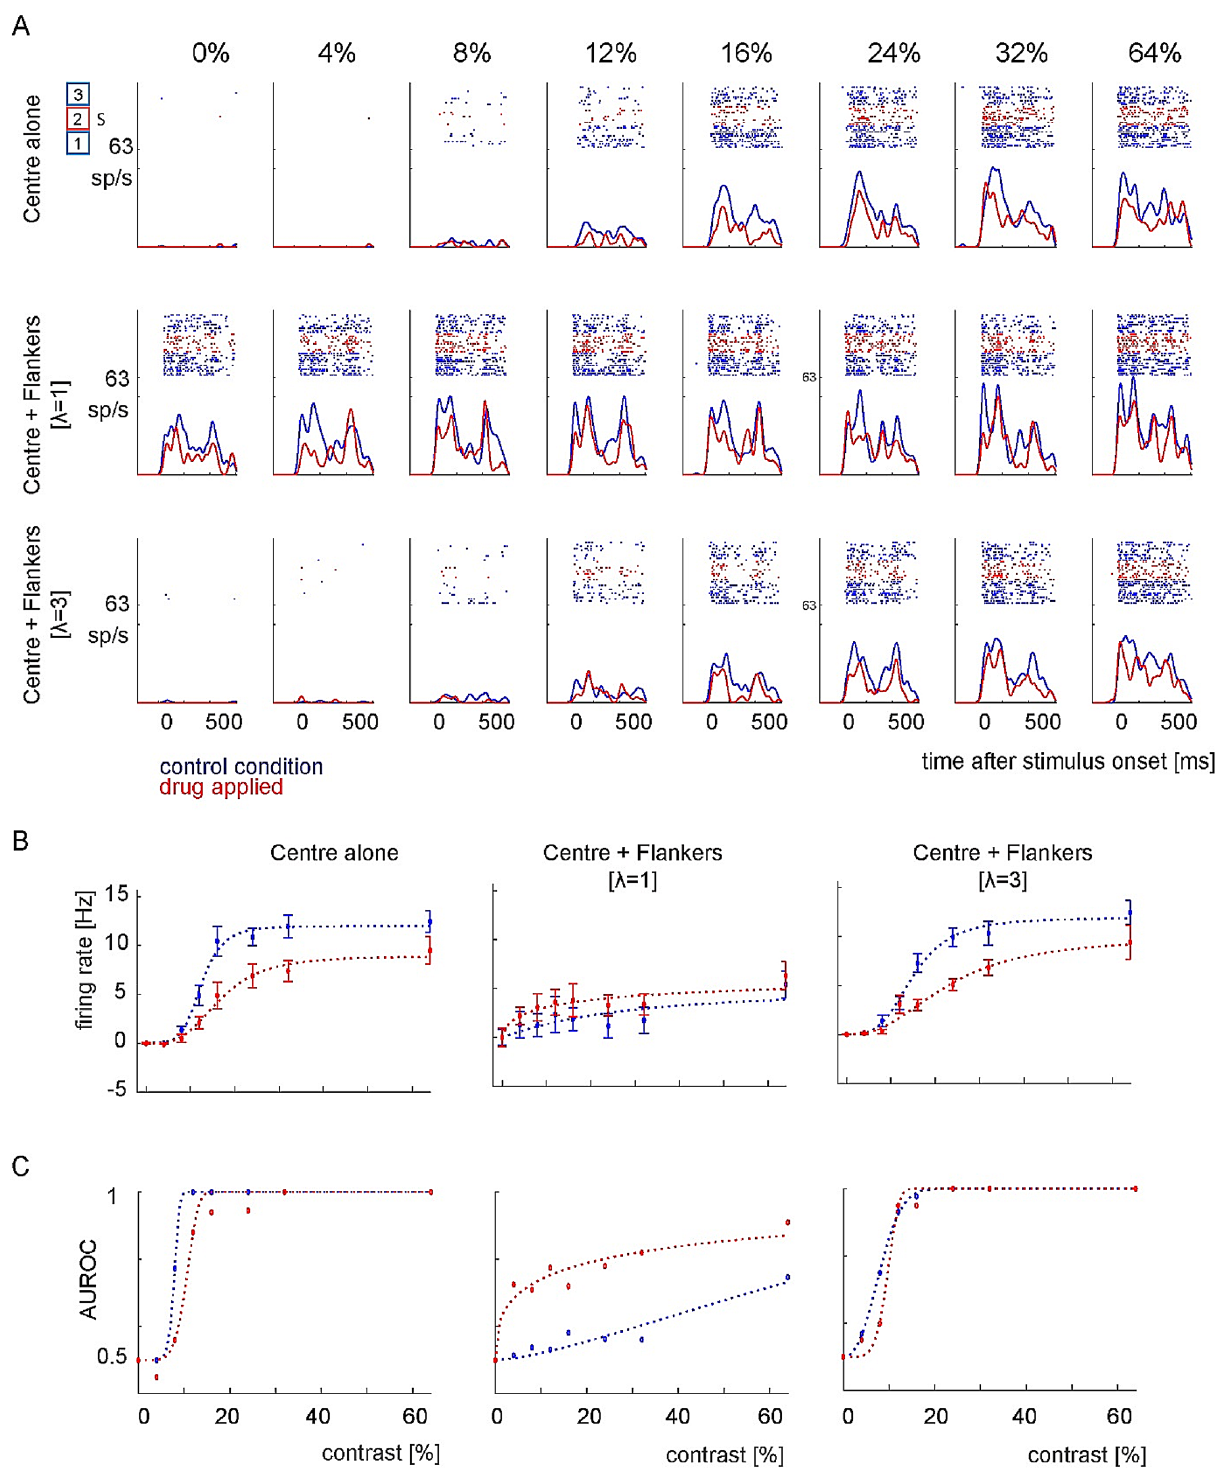
Figure 3. Effects of scopolamine on an example neuron. ( A ) All conventions as in Fig. 2A, except for S next to red box, which indicates that scopolamine was applied. The appearance of a central Gabor elicited a response that increased with the contrast of the stimulus. Scopolamine reduced firing rates. ( B ) Contrast R target functions. When only the central Gabor was presented scopolamine caused a reduction in Rmax. This was also the case when the central Gabor was shown along with flankers of 3λ. However, for the flanker of 1λ condition Rmax was increased by scopolamine. ( C ) AUROC values showing the strength of flanker facilitation under control (blue) and scopolamine-applied (red) conditions. Scopolamine resulted in increased contrast thresholds when no flankers were shown and when flankers of 3λ were shown, but it decreased contrast thresholds when flankers of 1λ were